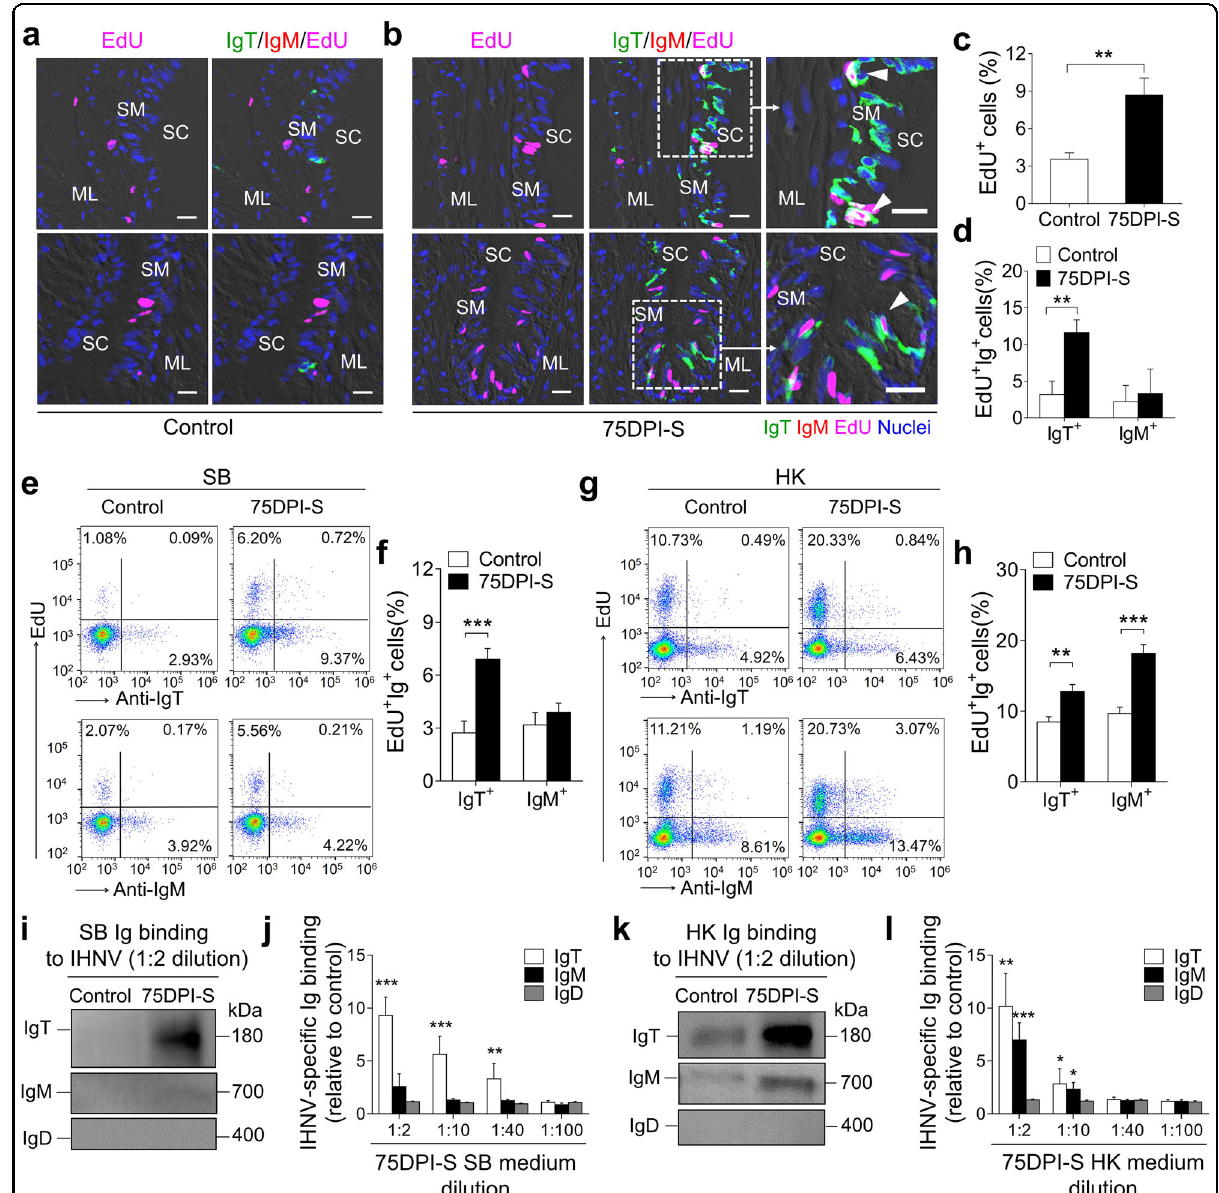
Fig. 5 Proliferative responses of B-cells upon IHNV infection and local Ig-speci fi c responses in tissues explants of 75DPI-S fi sh. a , b Immuno fl uorescence analysis of EdU incorporation by IgT + or IgM + B-cells in SB mucosa of control ( a ) and 75DPI-S ( b ) fi sh. SB paraf fi n-sections were stained for EdU (magenta), trout IgT (green), trout IgM (red), and nuclei (blue). White triangles within enlarged images of the areas outlined in b point to proliferative (double-stained for EdU and IgT) IgT + B-cells ( b , right). SC SB cavity, SM SB mucosa, ML muscle layer. Scale bars, 20 μ m. c , d Percentage of EdU + cells from total SB cells ( c ) and total IgT + or IgM + B-cells populations ( d ) in SB mucosa of control or 75DPI-S fi sh counted from a and b ( n = 15). e Representative fl ow cytometry dot-plots showing proliferation of IgT + and IgM + B-cells in SB leukocytes of control and 75DPI-S fi sh. The percentage of lymphocytes representing proliferative B-cells (EdU + ) is shown in each dot plot. f Percentage of EdU + cells from the total SB IgT + or IgM + B-cell populations in control and 75DPI-S fi sh ( n = 12). g Representative fl ow cytometry dot-plots showing proliferation of IgT + and IgM + B-cells in HK leukocytes of control and 75DPI-S fi sh. The percentage of lymphocytes representing proliferative B-cells (EdU + ) is shown in each dot plot. h Percentage of EdU + cells from the total HK IgT + or IgM + B-cell populations in control or 75DPI-S fi sh ( n = 12). i – l Local IgT-, IgM- and IgD- speci fi c responses in SB and HK explant supernatants from control and 75DPI-S fi sh. i , k Western blot analysis of IgT-, IgM-, and IgD-speci fi c binding to IHNV in explant supernatants (dilution 1/2) of SB ( i ), and HK ( k ) from control and 75DPI-S fi sh. j , l IgT-, IgM-, and IgD-speci fi c binding to IHNV in dilutions of explant supernatants of SB ( j ) and HK ( l ) from control and 75DPI-S fi sh, measured by densitometric analysis of immunoblots and presented as relative values to those of control fi sh ( n = 8 – 10). Statistical differences were performed by unpaired Student ’ s t -test. Data in c , d , f , h , j , and l are representative of at least three independent experiments (mean± SEM). * P < 0.05, ** P < 0.01, and *** P <